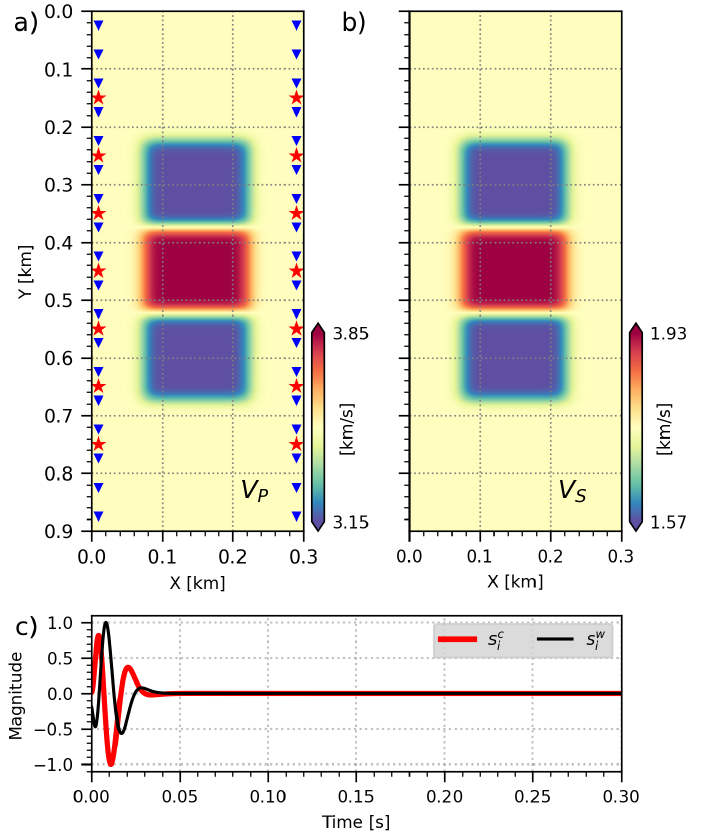
Figure 3. ( a , b ) are the true V P and V S model structures; ( c ) The red and black lines indicate the correct and wrong source wavelets ( s c and s w ). The red stars and blue triangles in ( a ) indicate the locations i i of sources and receivers,